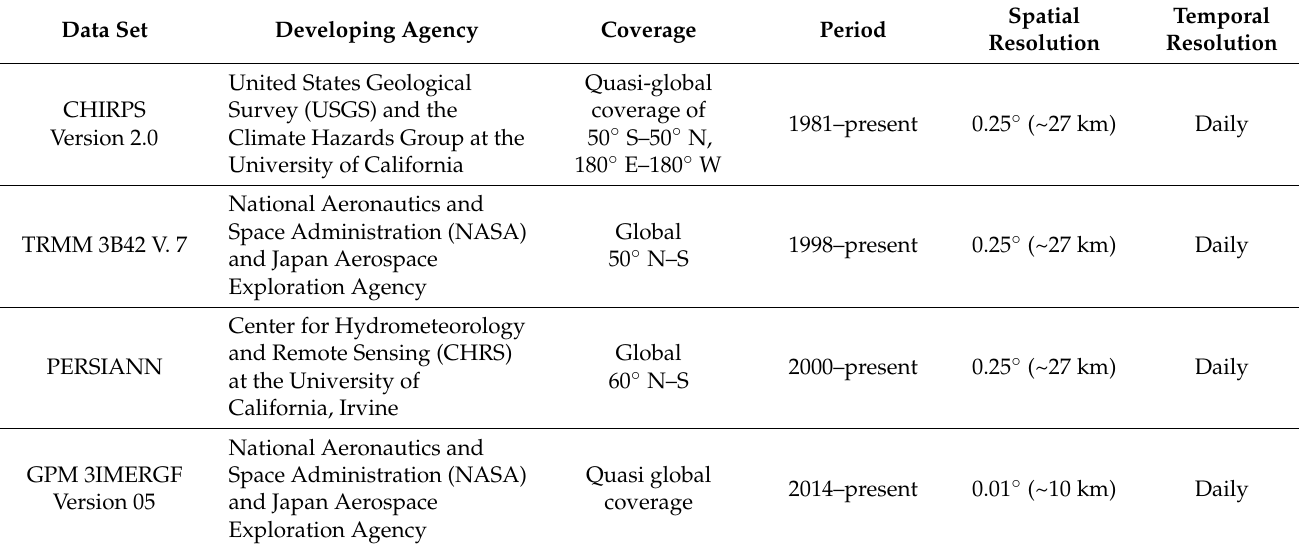
Table 1. Overview of satellite-based precipitation